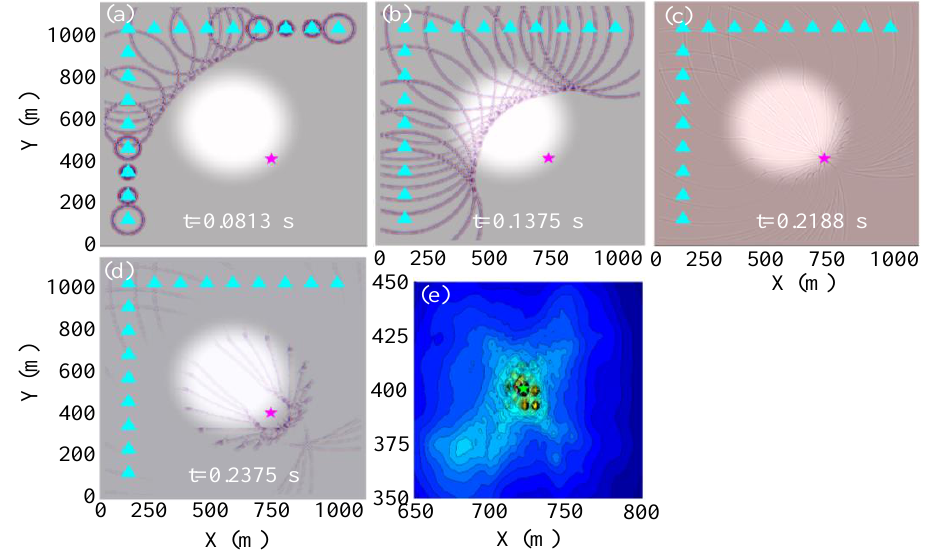
Figure 3. Location results of the GBRTM location method when using the Ricker wavelet with a dominant frequency of 200 Hz for synthetic test. ( a – d ) Stacking back propagation wavefields from each sensor at different time based on Gaussian beam modeling. The background is the 2D velocity model and the pink star indicates the true location of the test source. ( e ) Stacking amplitude imaging of back propagation wavefields at points near the true source based on autocorrelation imaging condition. The green star shows the source location determined by the GBRTM location method, which almost covers the true source location represented by a pink star.